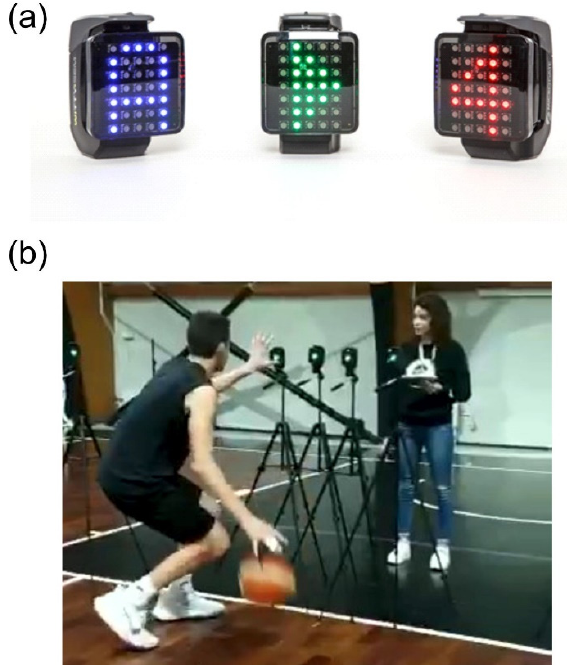
Figure 2. ( a ) Interactive display devices showing some of the possible visual outputs. ( b ) Video frame showing a snapshot of the CM-DT training.